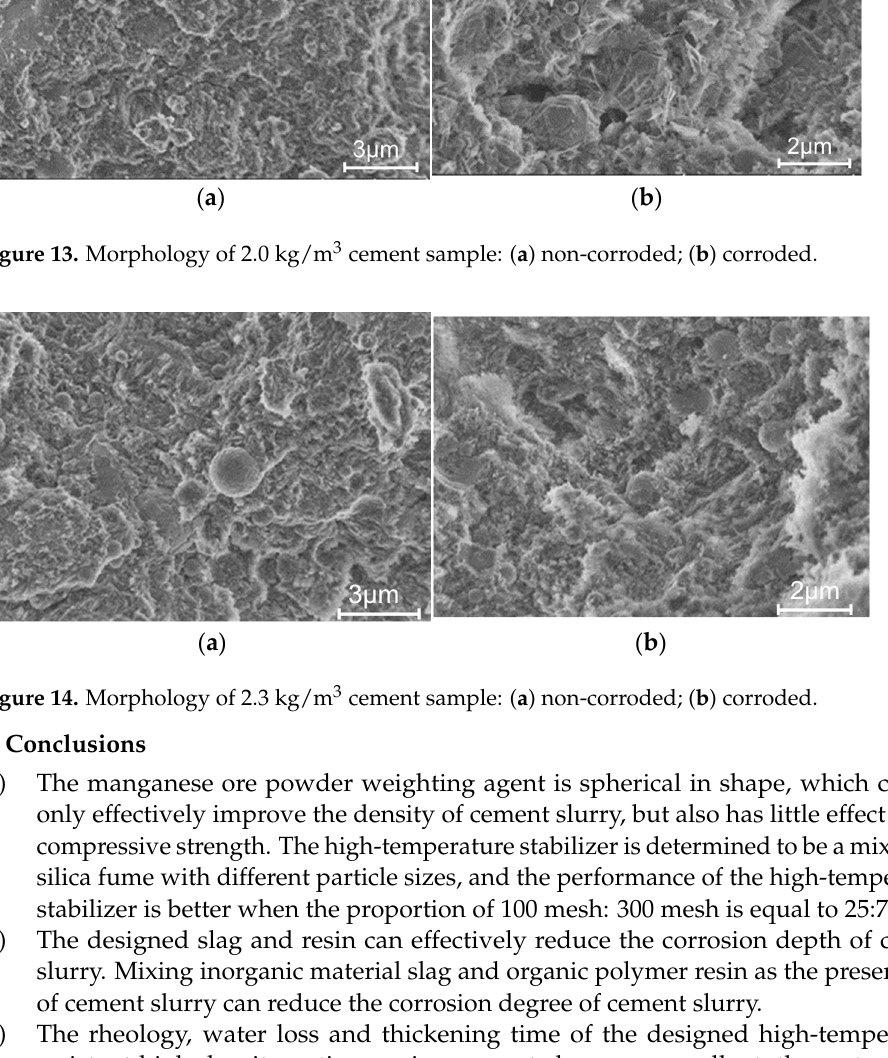
Figure 12. Compressive strength of cement samples with di ff erent corrosion times.